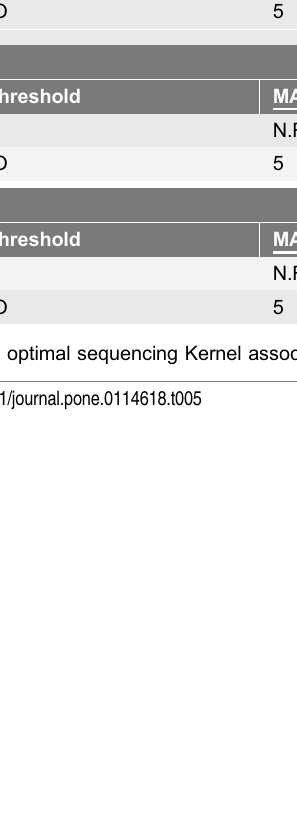
Table 6. Rare/uncommon (MAF , 5%) variants analysis with lipid traits in African Blacks. HDL-C MAF Threshold MAF( #